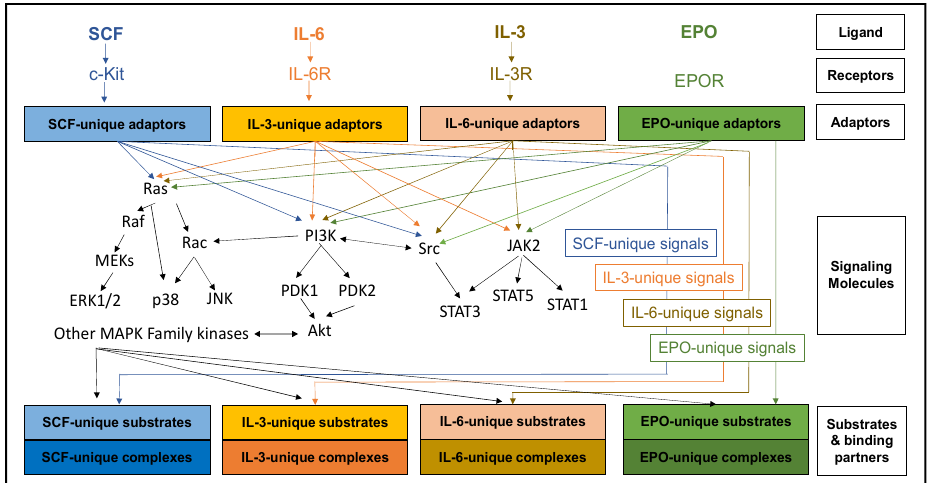
Figure 2. Despite regulating vastly distinct physiological responses to erythropoiesis, SCF, IL- 3, IL-6, and EPO share a large number of classical signaling cascades. The different physiological responses are probably due to nuanced regulation of these cascades with signal specific adaptors, substrates, binding partners, and accessory signaling molecules. The molecular landscape in which a signaling cascade is activated contributes as much to the physiological response as to the signal itself.